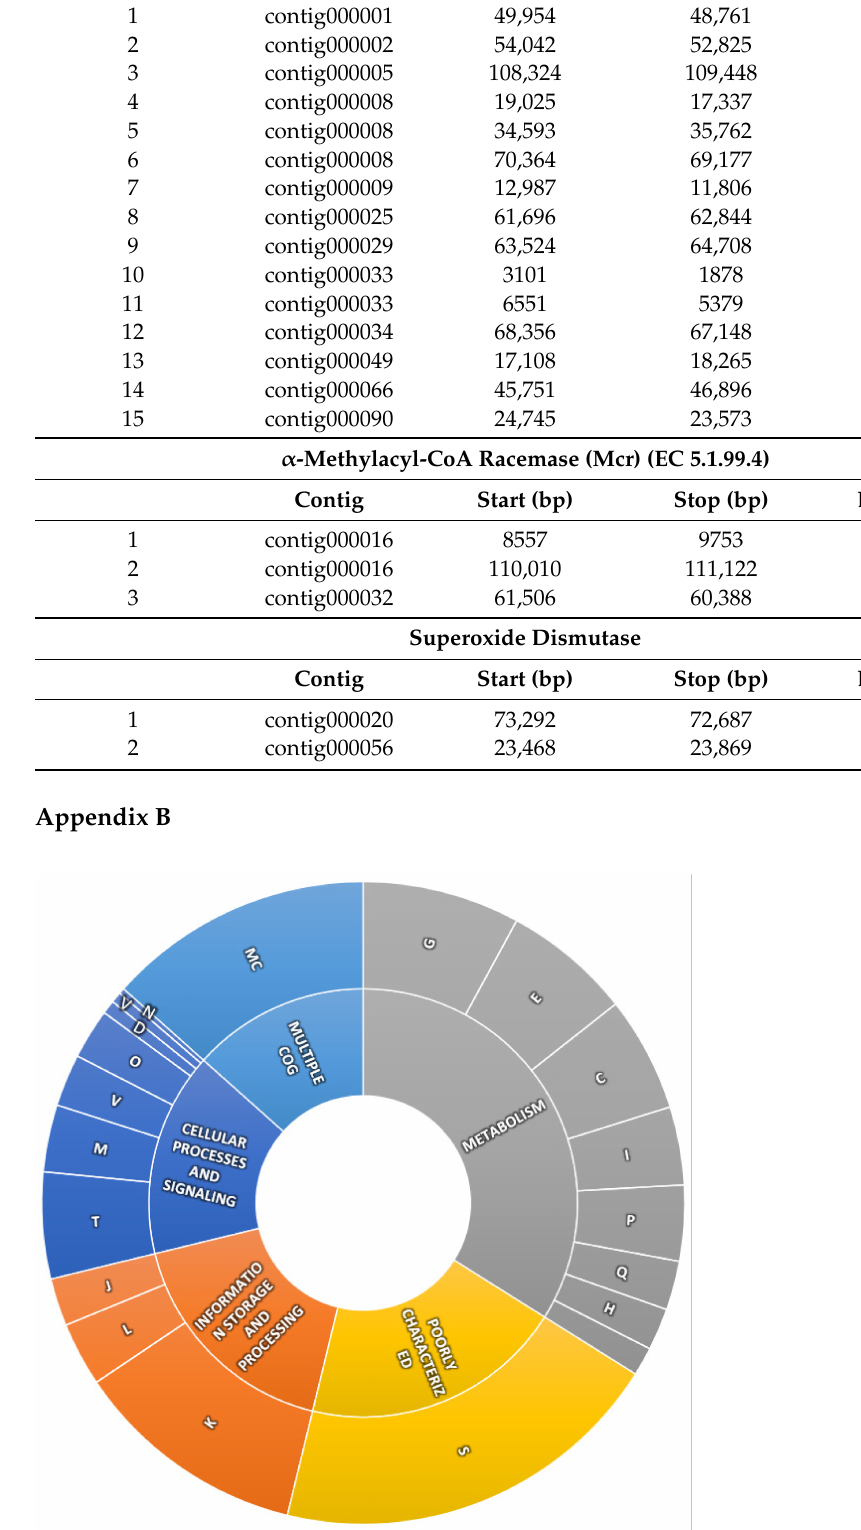
Figure A2. Cluster of Orthologous (COGs) for Dactylosporangium sp. AC04546 analyzed using egg-NOG mapper v.2 [42]. CELLULAR PROCESSES AND SIGNALING [D] Cell cycle control,